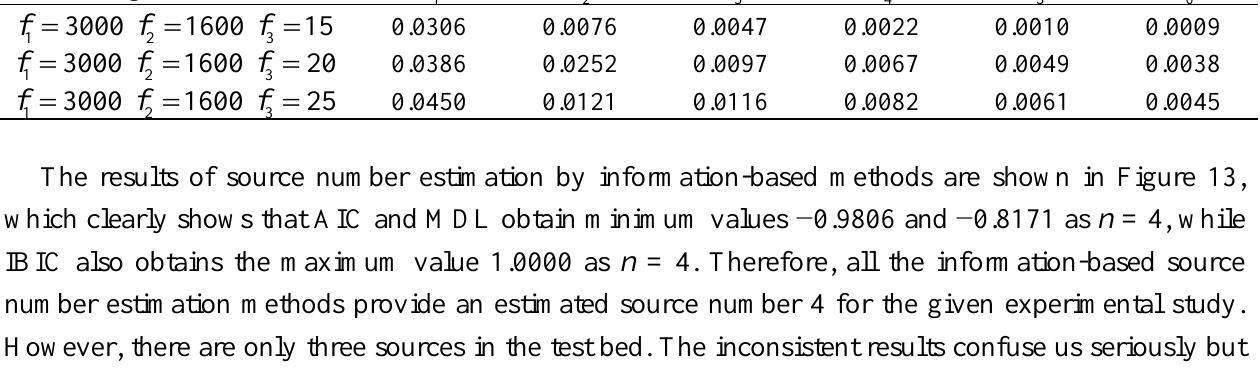
Table 4. The eigenvalues of the covariance matrix for the mixed signals.